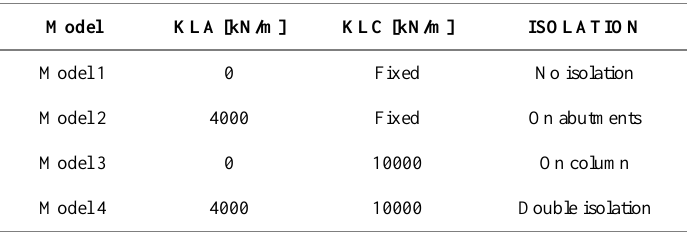
Table 1. Characteristics of the various models.